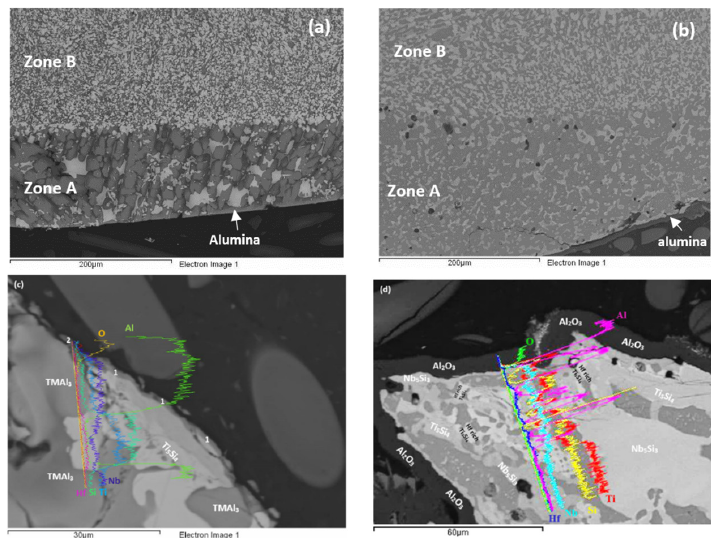
Figure 13. SEM back scatter electron images of cross sections of oxidised specimens of the alloy Nb 1.3 Si 2.4 Ti 2.4 Al 3.5 Hf 0.4 ( a ) at 800 °C and ( b ) at 1200 °C; ( c ) line scan at 800 °C, 1 indicates Si containing